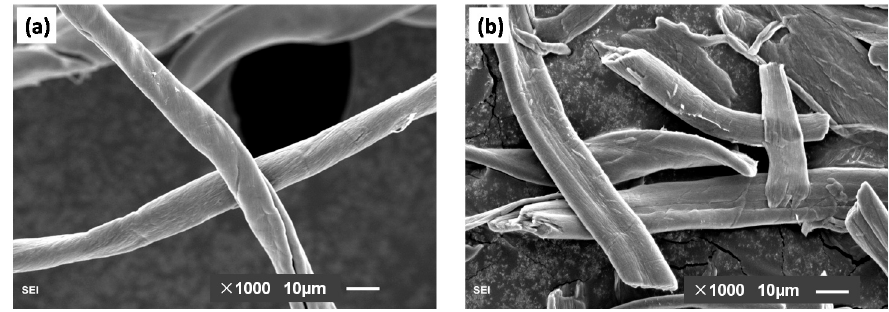
Figure 1. SEM image of ( a ) cotton fibers and ( b ) MCC fibers. Table 1. Chemical composition, physical and mechanical properties of Portland cement used. Compound Mass wt./%